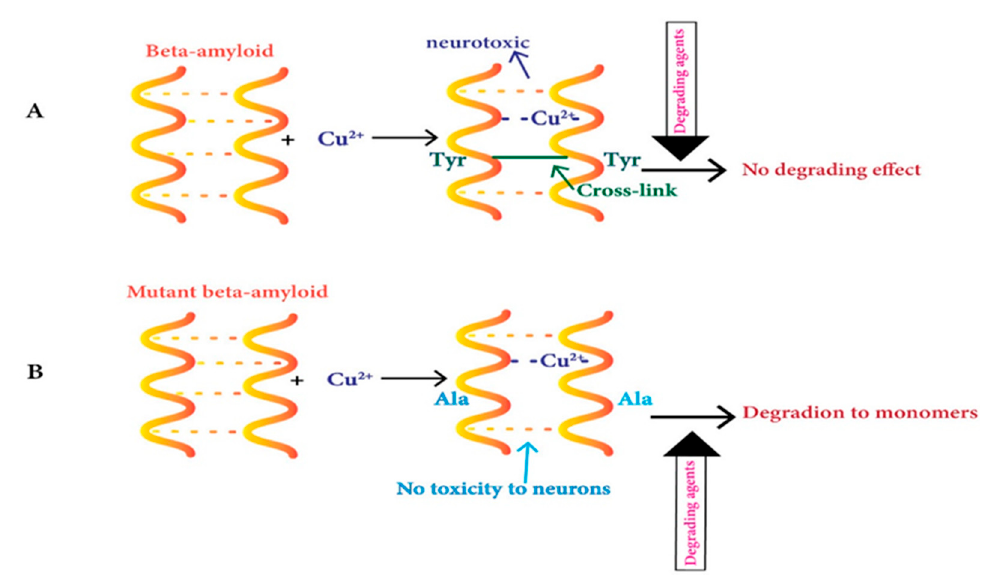
Figure 1. Copper’s role in the aggregation of A β peptides in the neuritic plaques of Alzheimer’s disease. ( A ) Cu2+ complexes with beta-amyloid peptides lead to dityrosine-linked β -amyloid dimer formation, which is neurotoxic and resists degradation into monomers. ( B ) Cu binding with the Y10A mutant peptide causes no neurotoxicity, dityrosine cross-linking, and degrades to monomers via degrading agents. Table 1. Copper ions’ e ff ects on selected metal-binding proteins implicated in Alzheimer’s disease. Protein. E ff ect Animal and Cell